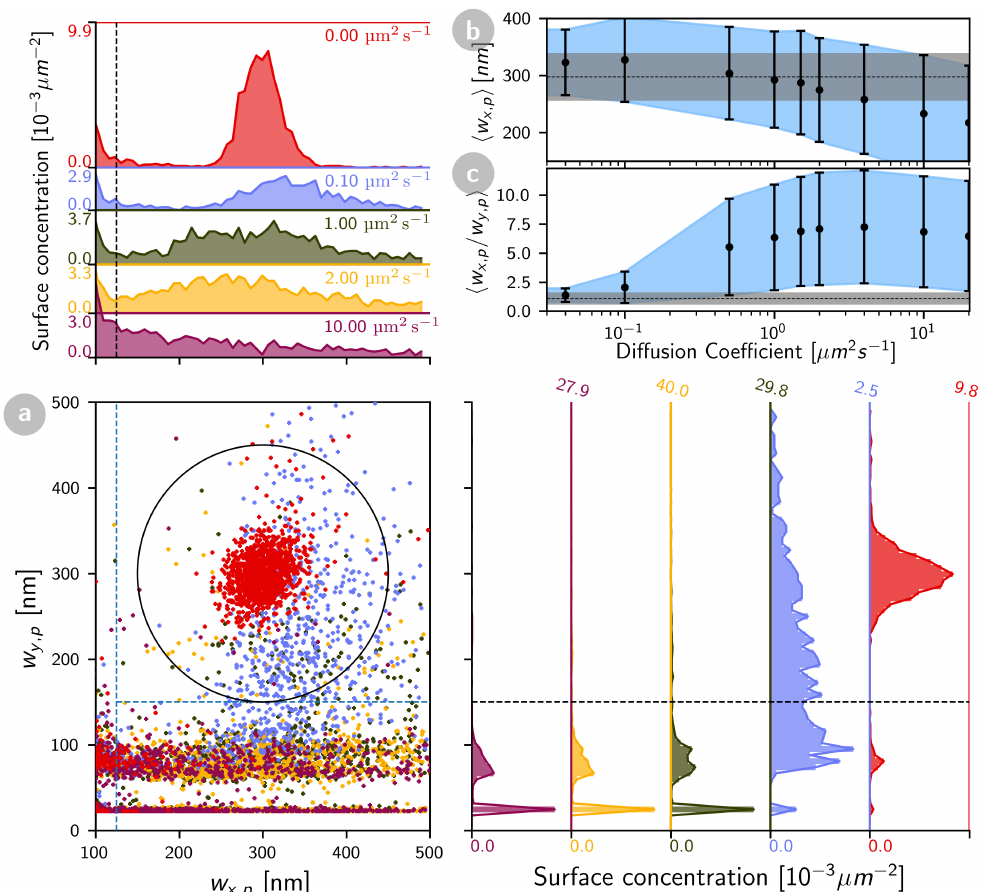
Figure 2. Influence of particle diffusion coefficient on the appearance of events detected in simulated confocal images. Simulation parameters were otherwise the same as in Figure 1. ( a ) Distribution of w x , p and w y , p values for particles with different diffusion coefficients (red: 0µm 2 s − 1 , blue: 0.1µm 2 s − 1 , green: 1µm 2 s − 1 , yellow: 2µm 2 s − 1 , purple: 10µm 2 s − 1 ). ( b ) Average streak length and ( c ) average eccentricity of all events with w x , p > 120 nm (error bars are the standard deviation) as a function of diffusion coefficient. The dashed line and the grey area represents the values obtained for stationary